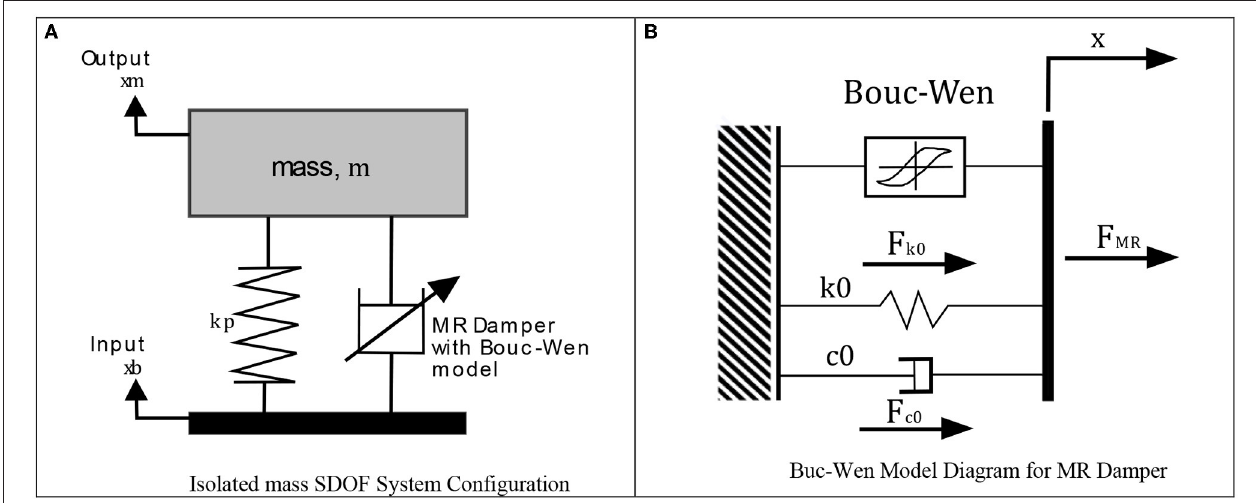
FIGURE 8 | Diagrams for the configuration of semiactive orthosis. (A) Isolated mass SDOF system configuration. (B) Buc-Wen model diagram for MR